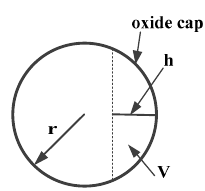
Figure 2. Model of oxide deposition on the aluminum particle surface.